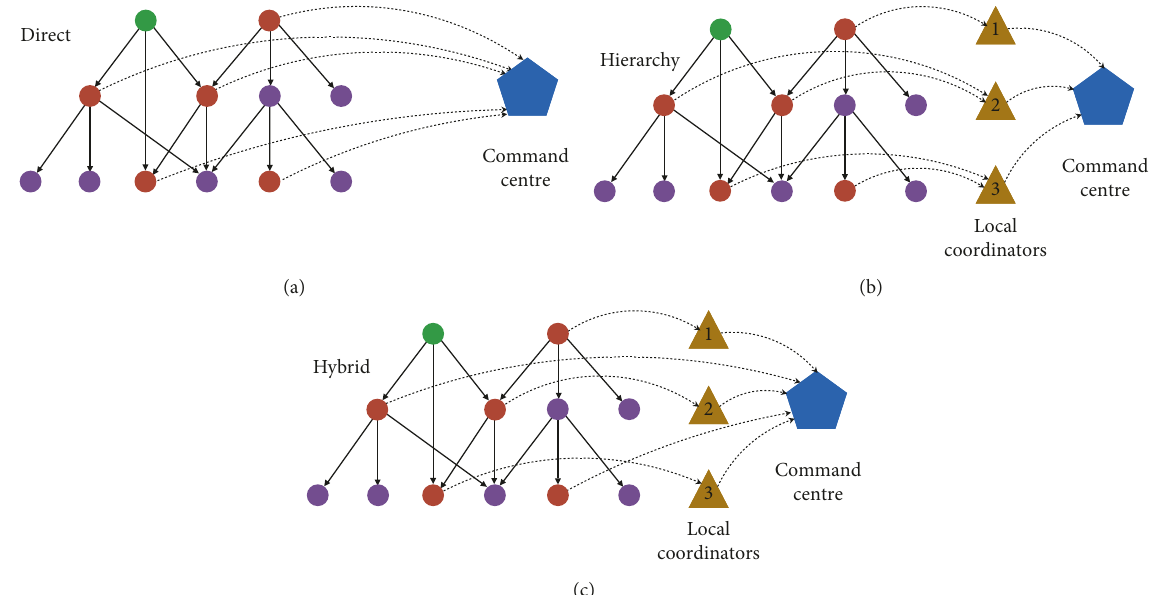
Figure 3: (a) Direct : all disrupted nodes report to command centre directly. (b) Hierarchy : all disrupted nodes report to their respective local coordinator. Each local coordinator will wait until it receives information from all disrupted nodes of its respective level before it reports to command centre. (c) Hybrid : mixed of direct and hierarchy reporting